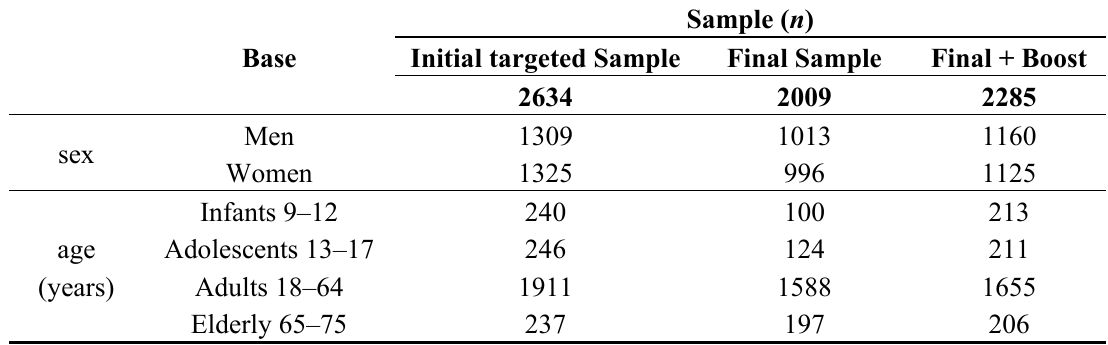
Table 1. Distribution of the sample for the ANIBES